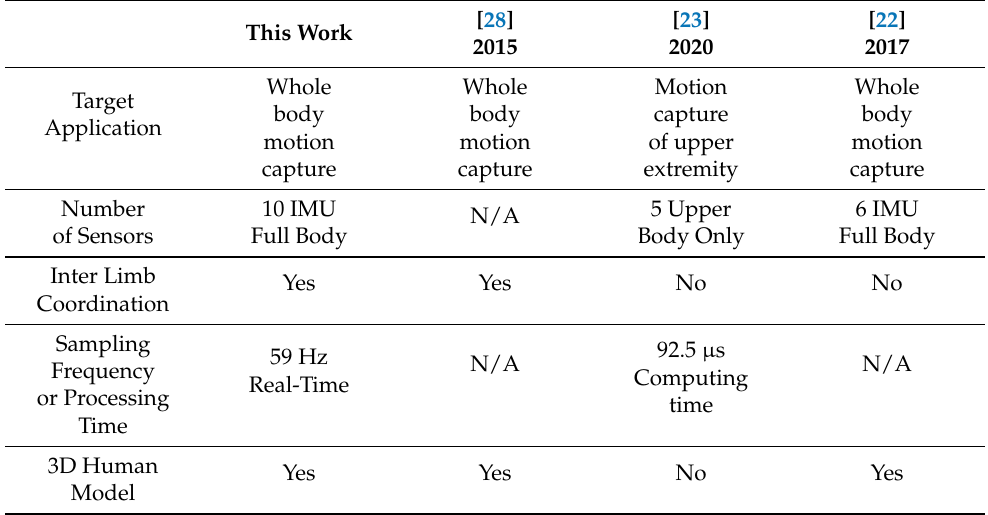
0.10.20.30.40.50.60.7 00.010.020.030.04 Box Plot of Limb Angle Cross Correlations Box Plot of Limb Angle Cross Correlations Between Different Samples Between the Same Sample Figure 6. Interlimb cross-correlation results from the same trial ( left ) and different trials ( right ). The correlation coefficient shows that the limbs coordinates in the same trial. The cross-correlation results can be used to classify if the limbs are coordinating during walking, which would indicate abnormal gaits. Table 2. Performance comparison between the proposed system and recent reported similar systems. This